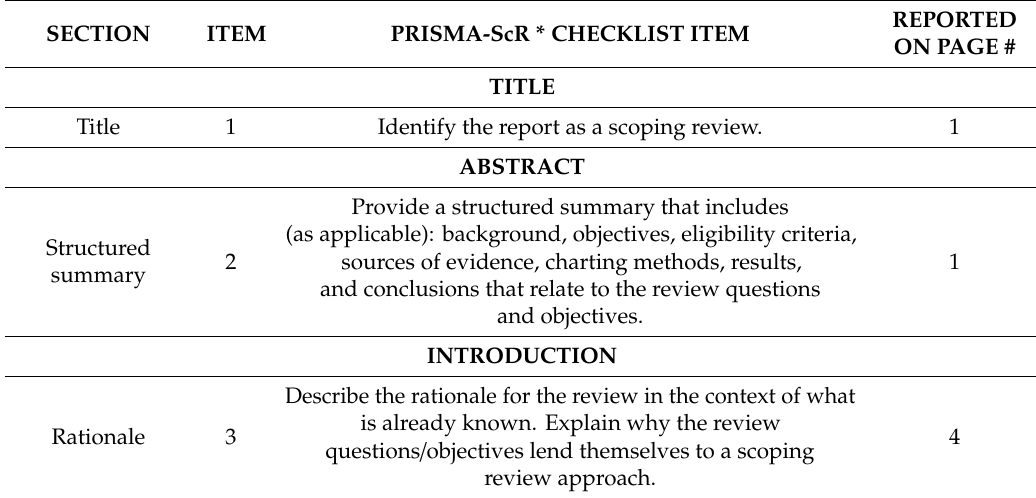
Table A2. PRISMA-ScR